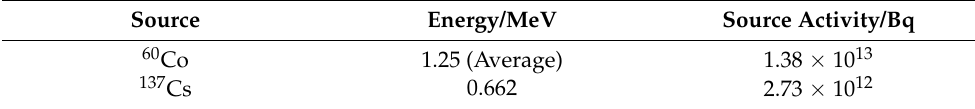
Table 3. Parameters of the γ rays source used in the